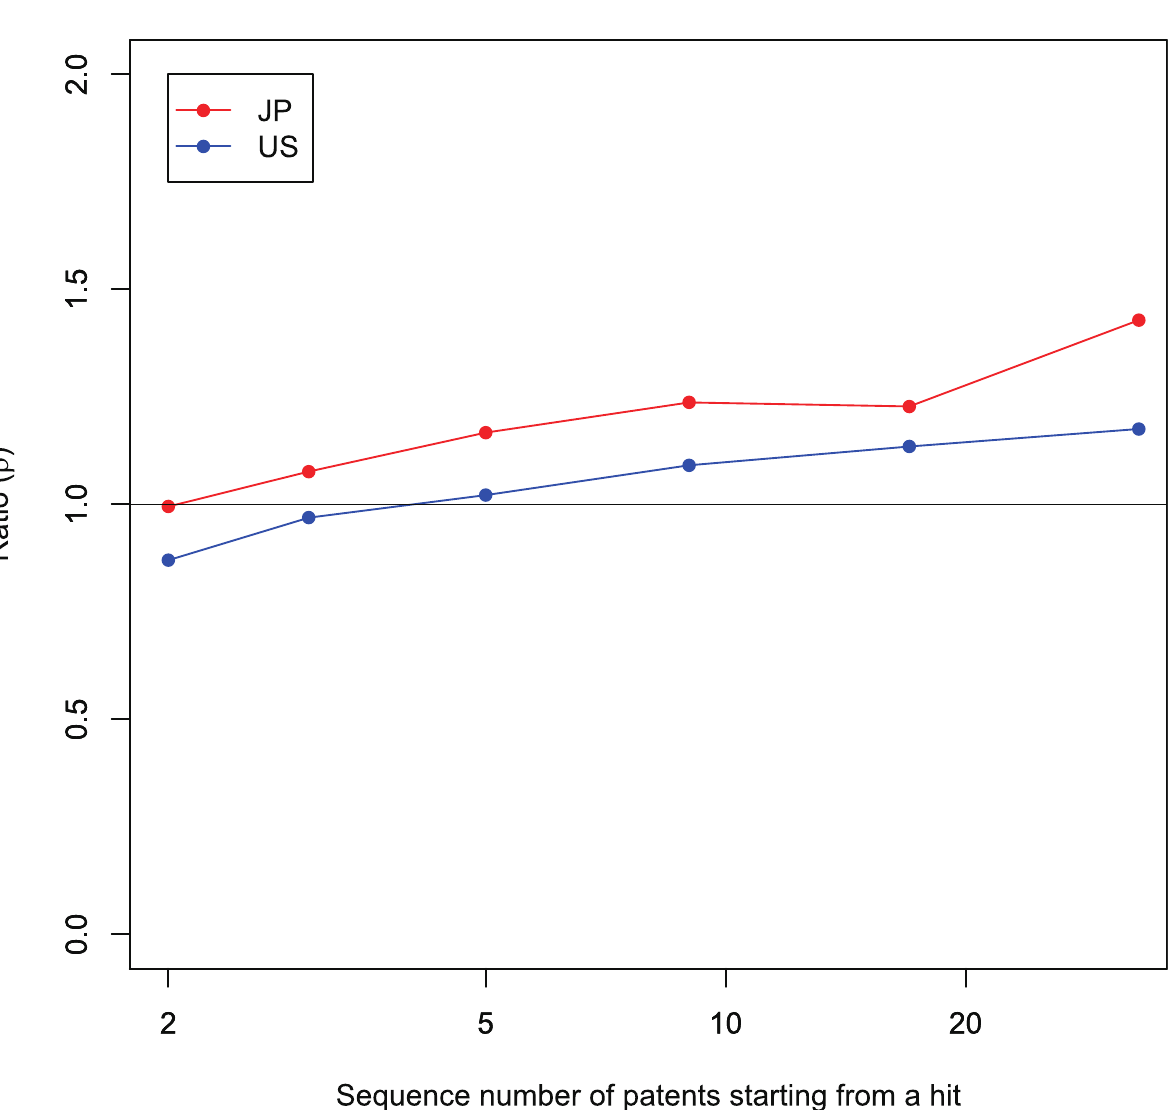
Fig 7. Relationship between ρ r and repetition. Horizontal axis is number of patents including a hit and all subsequent patents by the same team that made the hit. Vertical axis is ratio ( ρ r). Hits are patents with top 10% impact. Horizontal axis is cut so that number of samples is greater than approximately 100. Black horizontal line is ρ r =